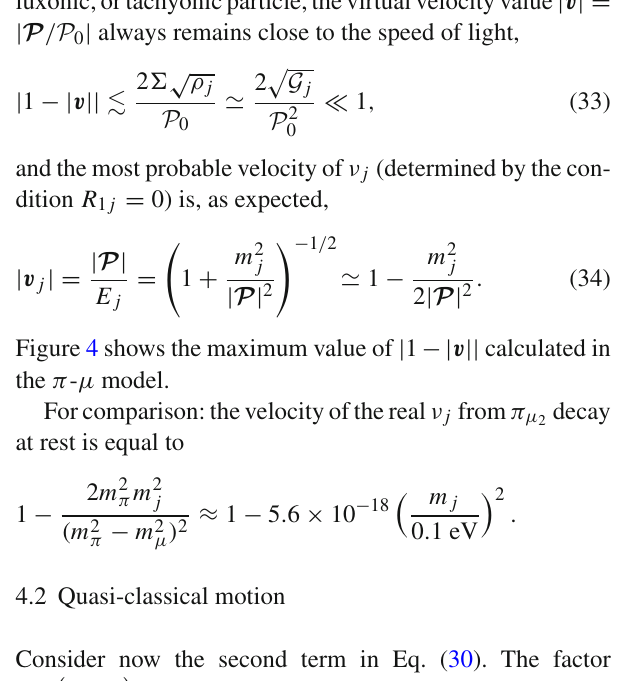
Fig. 4 Maximum permissible deviation of the virtual neutrino veloc- ity from the speed of light vs. σ π and σ μ estimated in the π - μ model. Calculation is made assuming energy–momentum conservation and neglecting the neutrino mass. The virtual neutrino energy in Eqs. (33) is taken equal to the real neutrino energy in the pion rest frame, that is, = ( m 2 − m 2 )/( 2 m π ) ≈ 29 . 8 P π μ 0